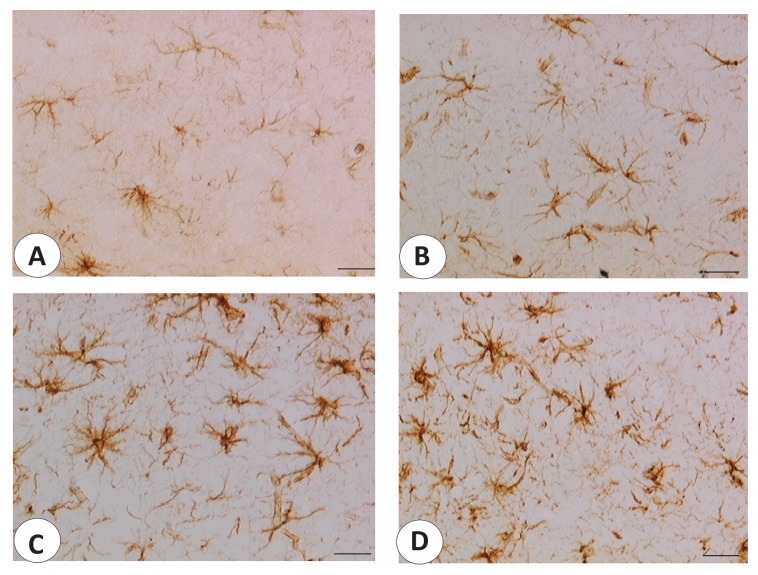
Sections of the frontal cortex (grey matter) processed for the immunohistochemical demonstration of glial fibrillary acidic protein (GFAP) in control WKY rats (A), control SHRs (B), SHR treated with (+/−)-thioctic acid 125 μmol/kg/day (C), SHR treated with (+/−)-thioctic acid 250 μmol/kg/day (D), SHR treated with (+)-thioctic acid 125 μmol/kg/day (E), and SHR treated with (−)-thioctic acid 125 μmol/kg/day (F). Calibration bar: 25 μm.